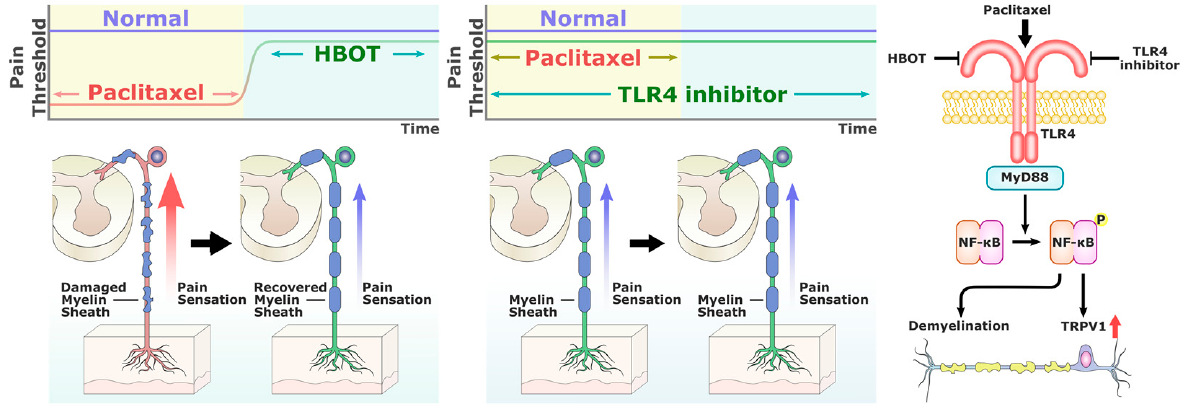
Figure 7. Summary of the effectiveness of HBOT in alleviating PAC-induced neuropathy by sup- pressing TLR4/MyD88/NF- κ B signaling and TRPV1 activation, and reducing axon demyelination.